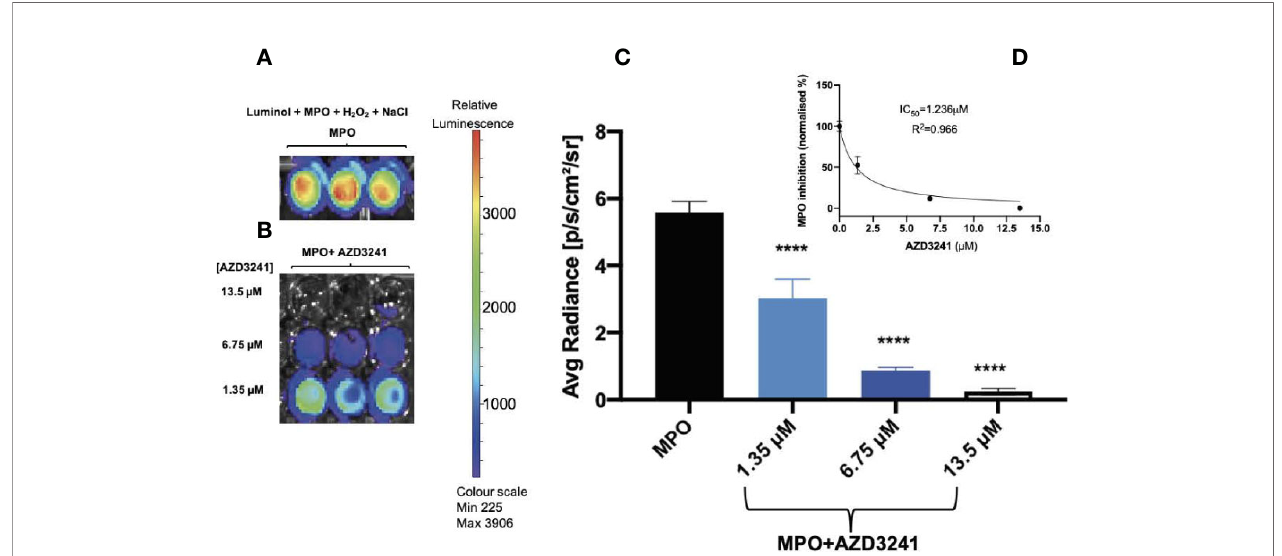
FIGURE 1 | AZD3241 inhibits myeloperoxidase (MPO)/hypochlorous acid (HOCl)-mediated oxidation of luminol in vitro . (A) MPO/HOCl-mediated oxidation of luminol in the presence of NaCl (150 mM). (B) Representative (C) dose dependent quantitative analysis of AZD3241 inhibition on MPO activity supplemented with NaCl and (D) Estimated IC 50 of AZD3241 from curve fi tting performed using GraphPad Prism software ( v 8). Right side vertical scale indicates the relative luminescence radiance shown as a heat map with relative radiance scale. Data in (C, D) represent mean ± SD quanti fi cation of three independent replicates measured in units of photons/sec/cm 2 /sr. ****Different to MPO control group ( p < 0.0001). On all fi gures “ AZD3241 ” is abbreviated as “ AZD ”